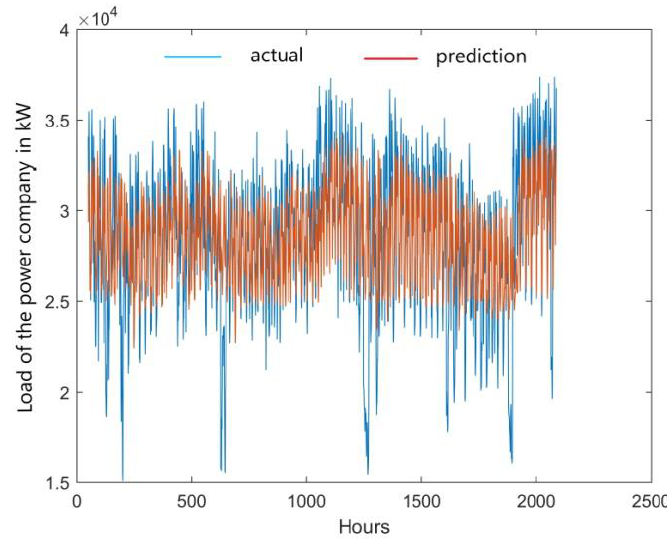
Figure 8. Root Mean Square Error (RMSE) as a function of epochs for the prediction model.